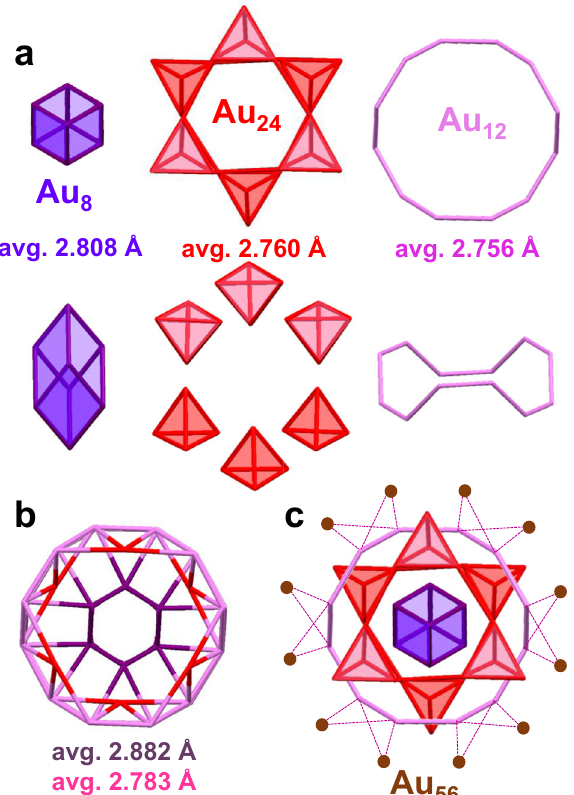
Fig. 3 Illustration of the bond lengths in the Au 56 NC. a Top and side views of the rhombohedral Au 8 kernel (purple), six tetrahedral Au 4 units (red), and a Au 12 ring (pink). b Connection of the Au 12 ring with the rhombohedral Au 8 and six tetrahedral Au 4 units. c Perimetric 12 Au atoms